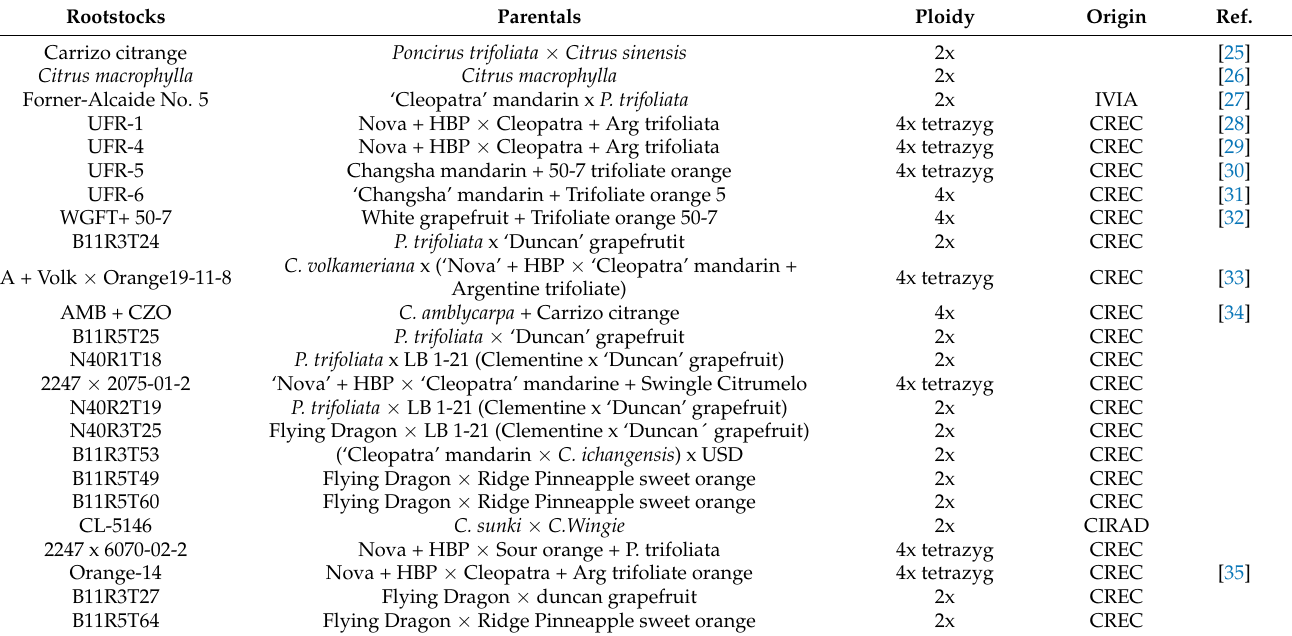
Table 1. Citrus rootstocks assayed against foot rot